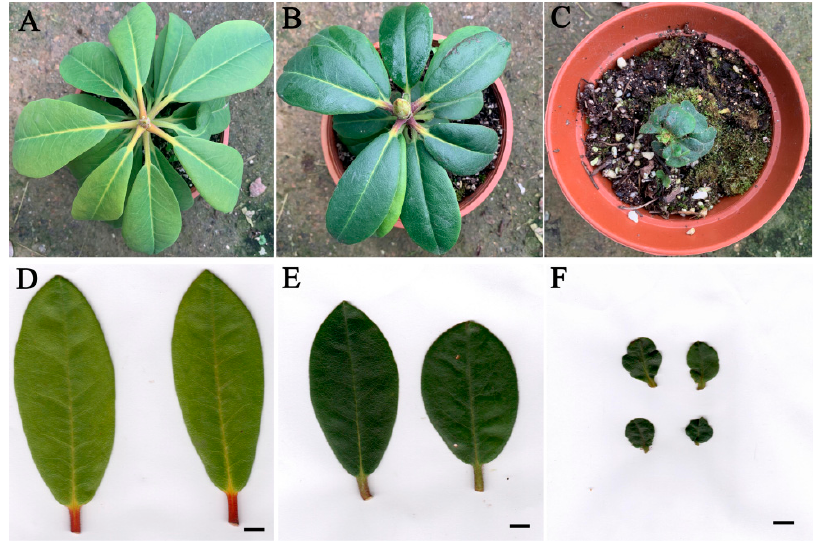
Figure 5. Comparison of morphological difference between 15-months old polyploid and diploid R. fortunei plants. ( A and D ), a diploid plant and its leaves; ( B and E ), a tetraploid plant and its leaves; ( C and F ), an octoploid plant and its leaves. Scale bar = 1 cm.